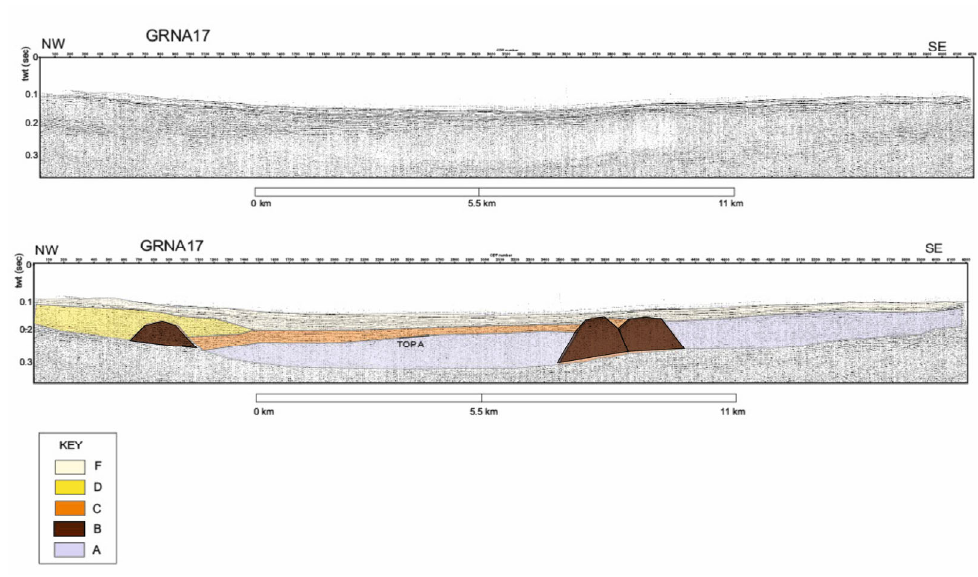
Figure 9. Seismic profile Grna17 and corresponding geologic interpretation.